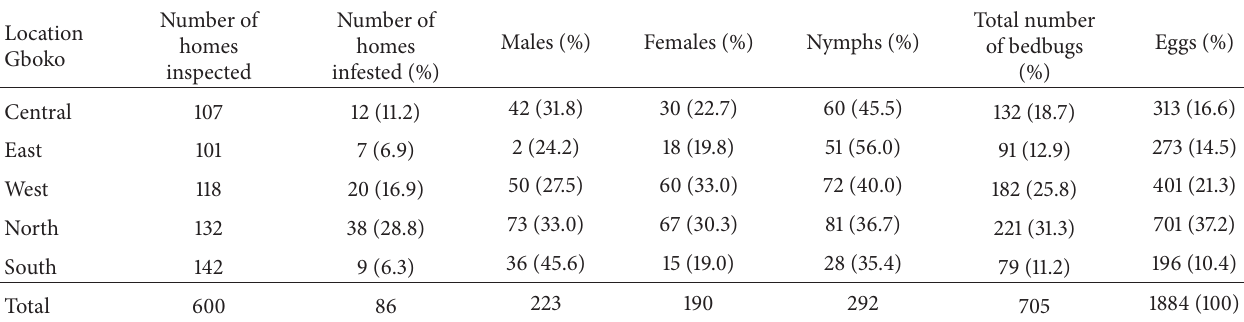
Table 1: Sex and growth stage of bedbugs ( Cimex lectularius ) collected from homes in Gboko. Location